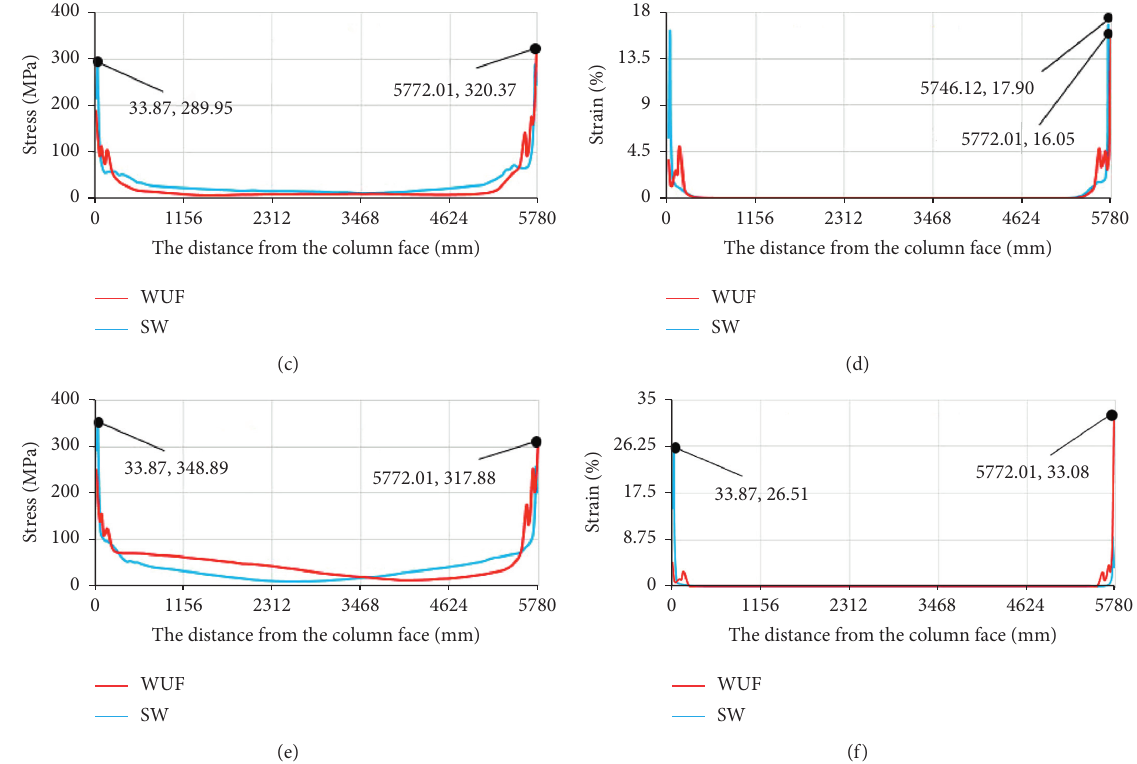
Figure 18: The values of stress and strain on SW and WUF along the beam in a three-story frame ( t � 15 s). (a) First story beam stress. (b) First story beam strain. (c) Second story beam stress. (d) Second story beam strain. (e) Third story beam stress. (f) Third story beam